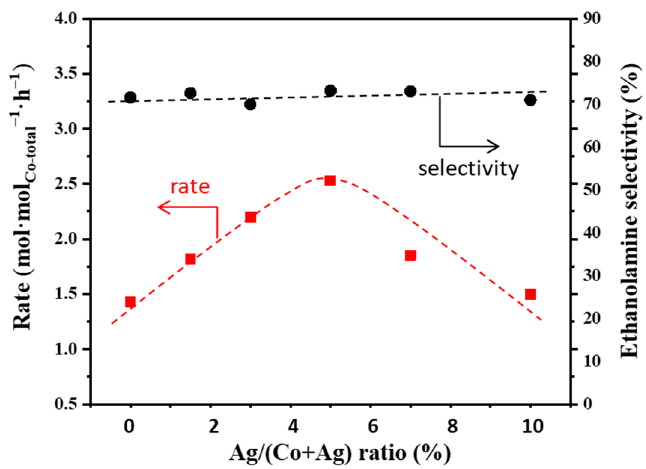
Figure 6. Effects of Ag content on the rate and selectivity of the Co-Ag/ γ -Al 2 O 3 (Co 5 wt%) catalysts in ammonolysis of ethylene glycol (453 K, 0.6 MPa NH 3 , 3.0 MPa H 2 , 0.067 mol/L ethylene glycol in tetrahydrofuran solution, controlled at ~20% conversion). Dashed lines indicate